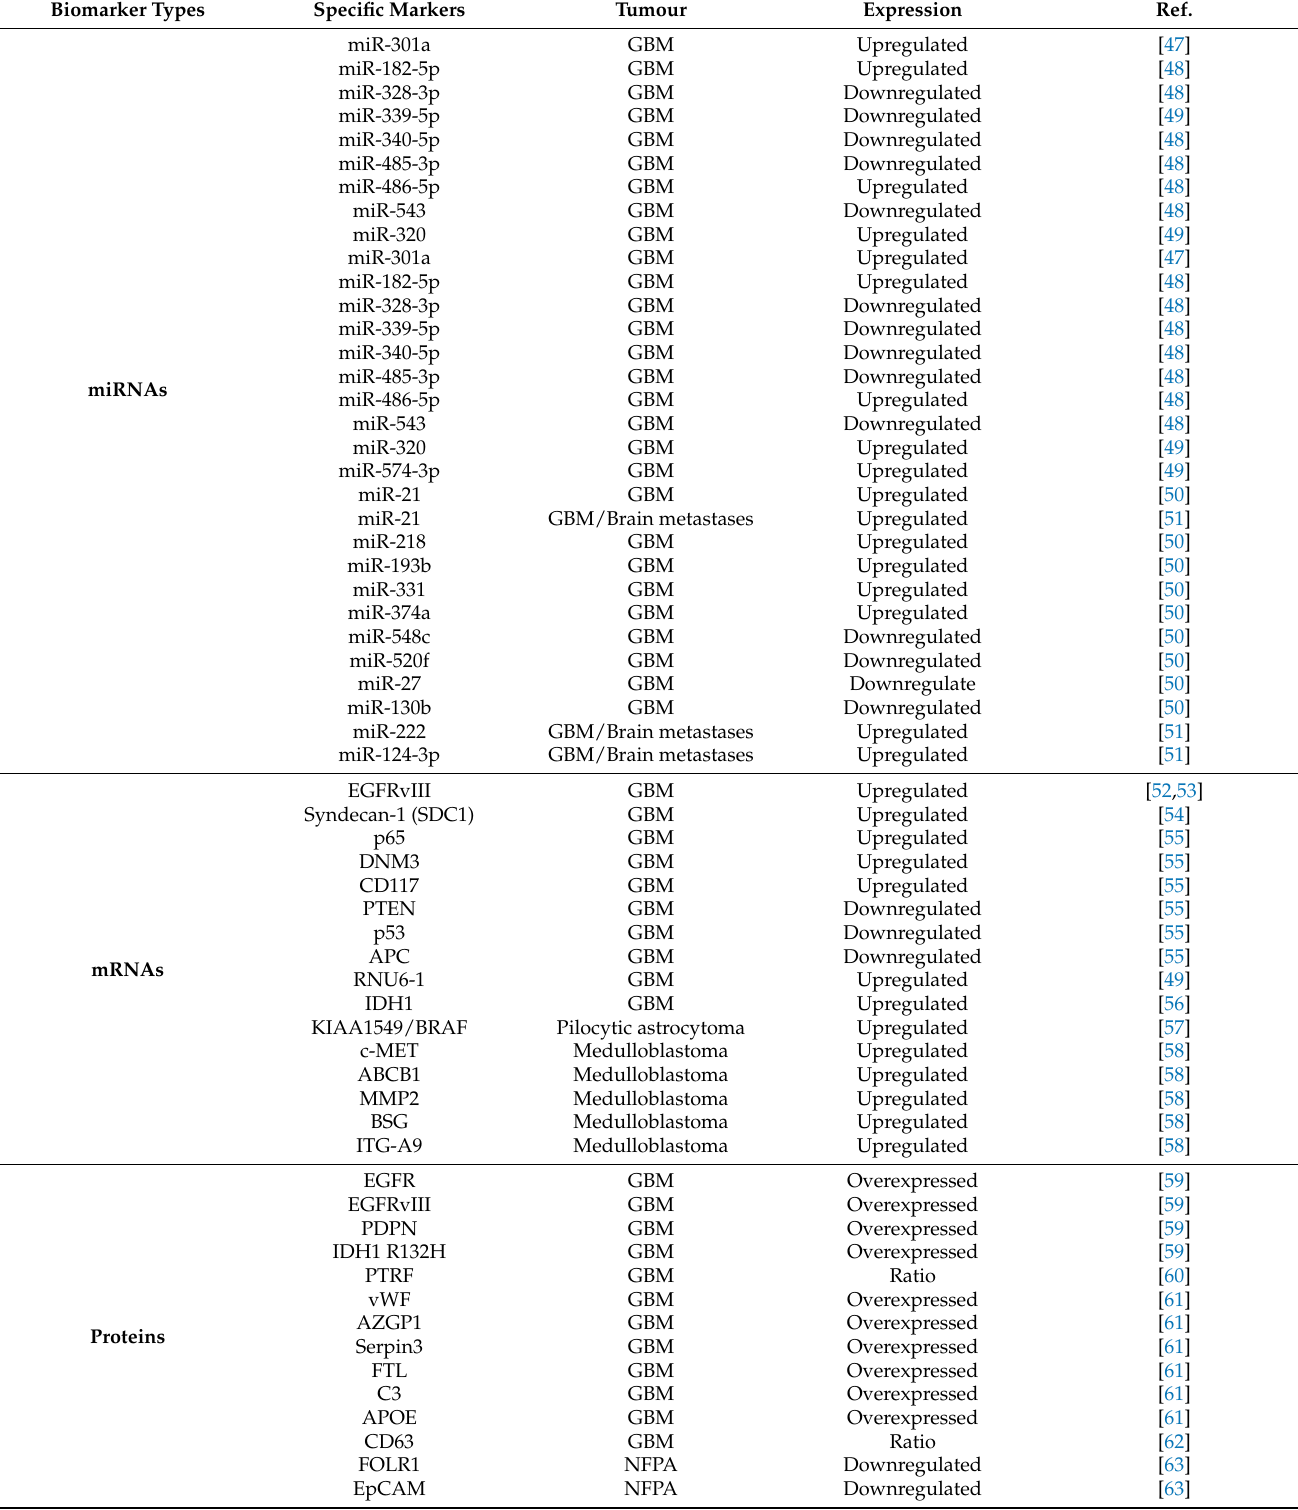
Table 3. EVs as potential biomarkers in CNS